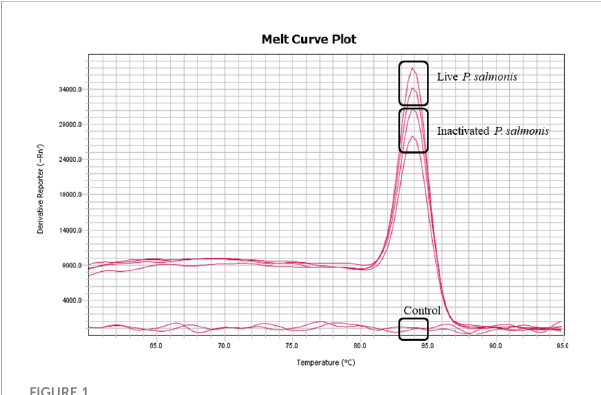
FIGURE 1 Detection of genetic material (DNA) of P. salmonis in the liver tissue at 14 dpi. Melting curve (Tm) of the 16s gene from P. salmonis ampli fi ed by qPCR of pooled DNA from each experimental